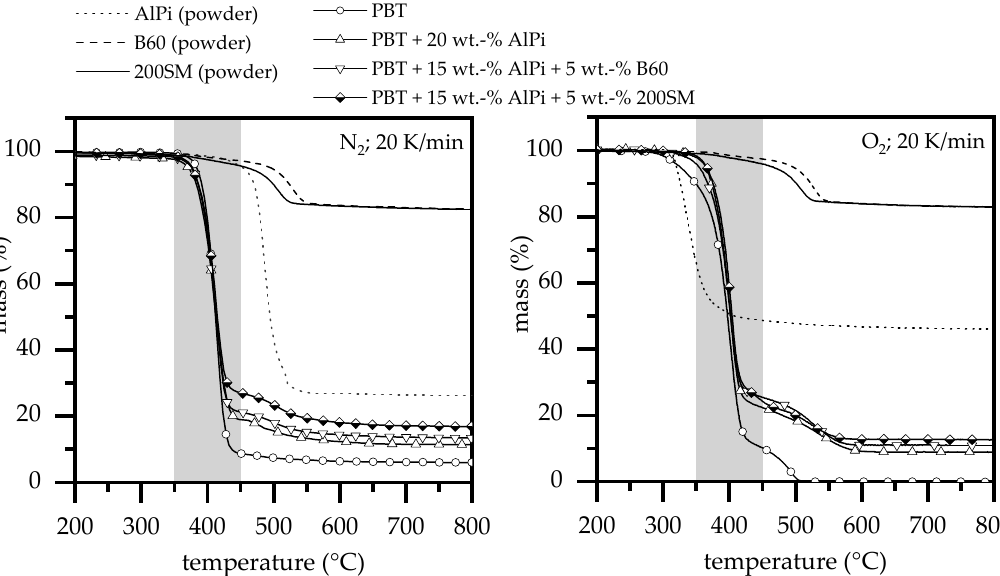
Figure 5. Thermogravimetric analysis (TGA) of all net materials and mixtures measured at a heating rate of 20 K / min. under nitrogen and oxygen atmosphere. Table 3. Important key values of TGA measurements of all material mixtures under nitrogen and oxygen atmosphere. N 2 O 2 Material Compositions